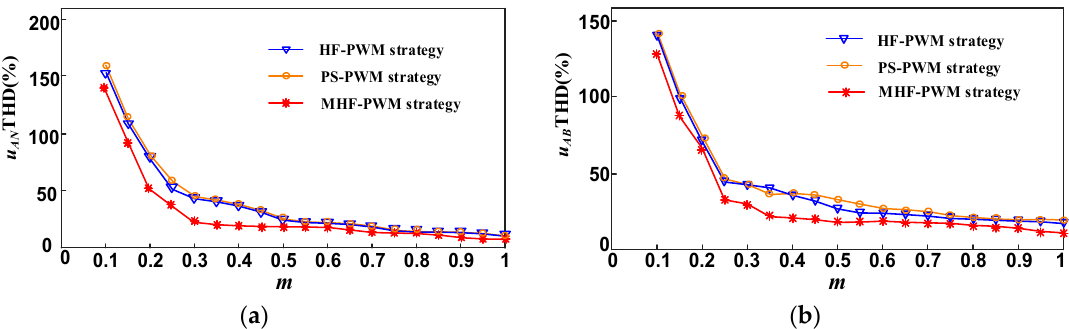
Figure 7. The corresponding curves of Total Harmonic Distortion (THD) and modulation of u AN and u AB under three modulation strategies. ( a ) Corresponding curve between the THD value of u AN and the modulation degree. ( b ) Corresponding curve between the THD value of u AB and the modulation degree.